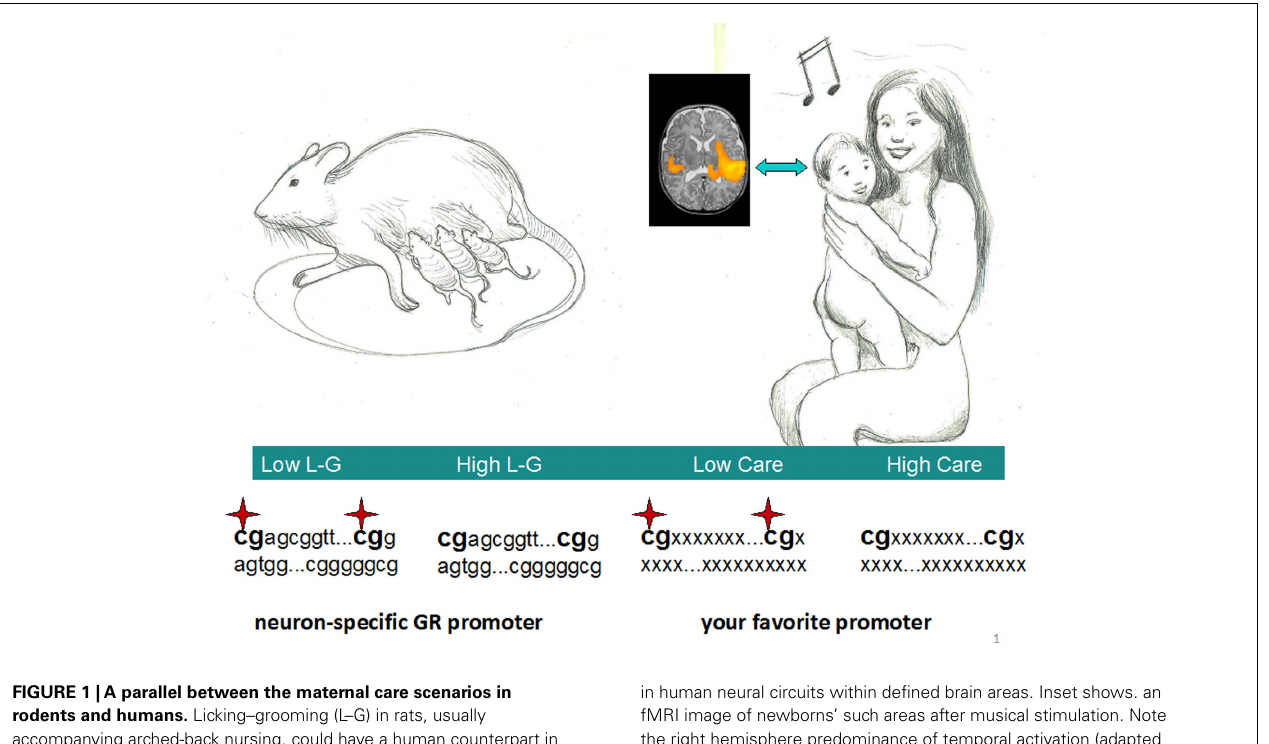
FIGURE 1 |A parallel between the maternal care scenarios in rodents and humans. Licking–grooming (L–G) in rats, usually accompanying arched-back nursing, could have a human counterpart in mothers embracing their child while chanting a lullaby.The demethylation in crucial promoters documented in rats could also occur